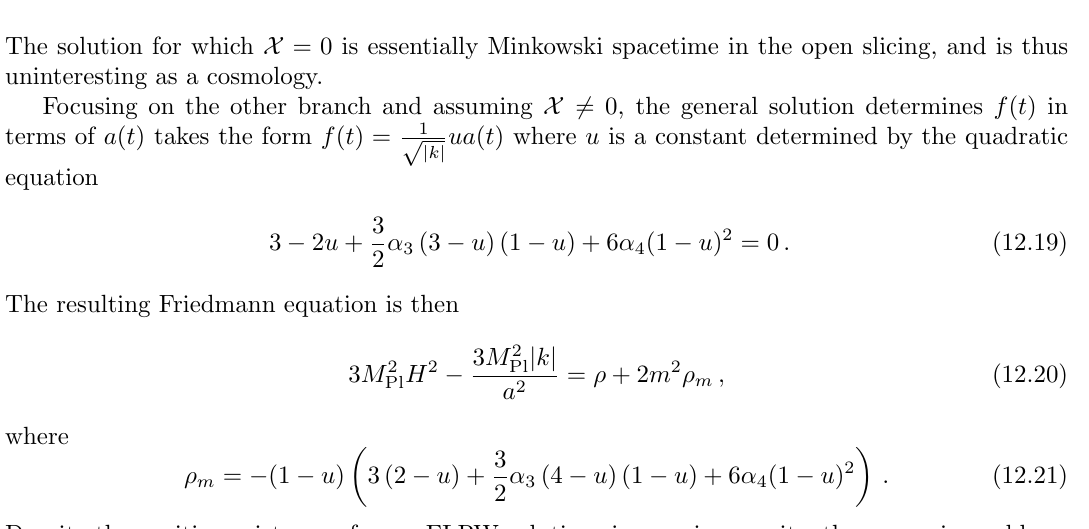
Figure 7: Alternative ways in deriving the cosmology in massive